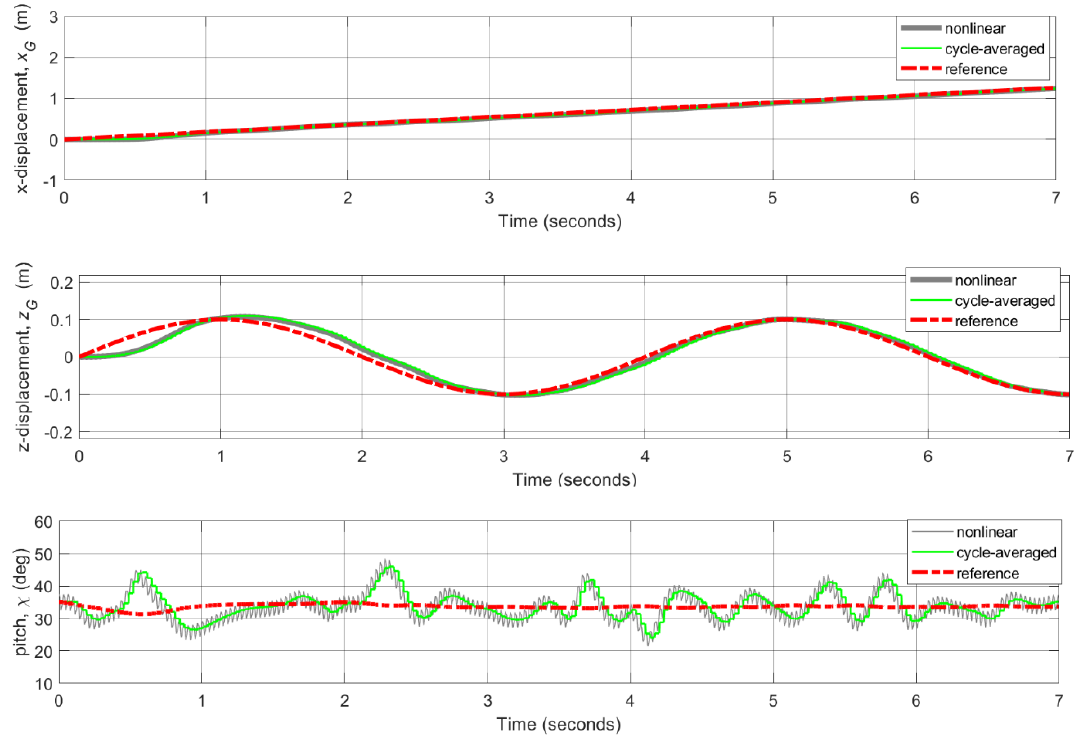
Figure 27. Flight control simulations for trajectories tracking control of nonlinear FWMAV model (case 3).